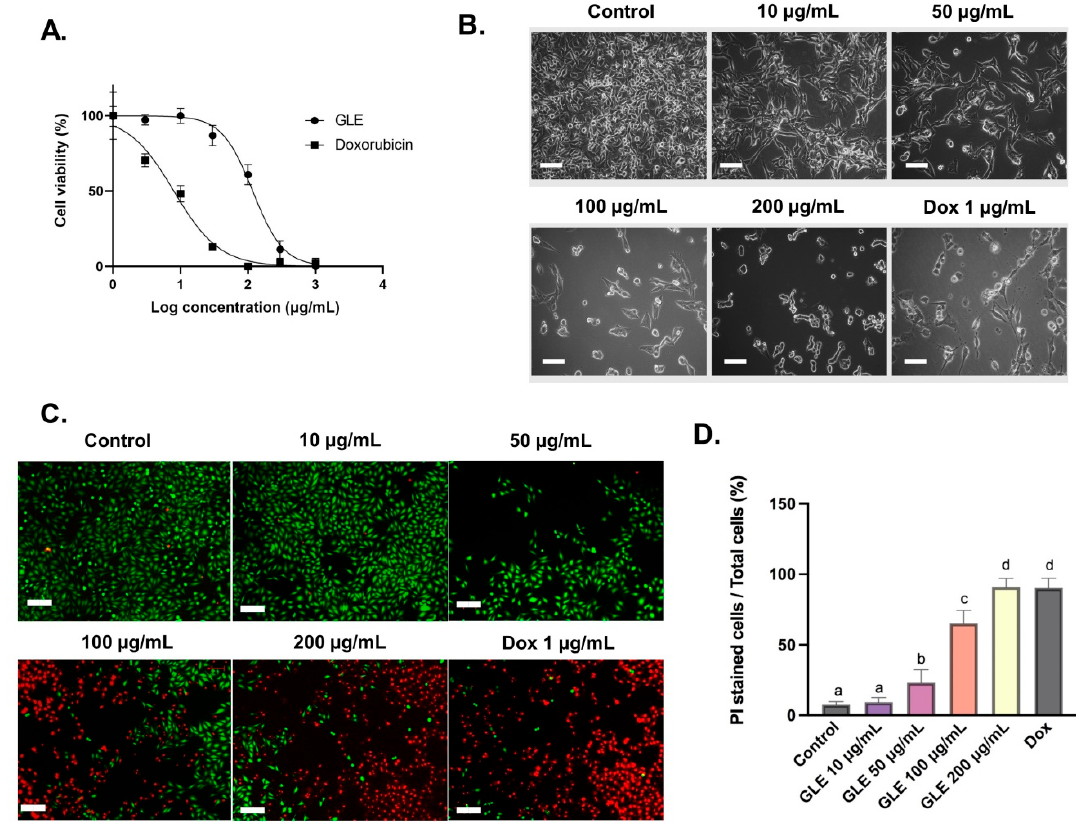
Figure 3. Cytotoxic effects of GLE in B16-F10 cells treated for 72 h: ( A ) The dose–response curve of GLE and doxorubicin (1–1000 µg/mL) cytotoxic activity in B16-F10 melanoma cells. ( B ) Morphological observation of B16-F10 melanoma cancer cells treated with GLE or doxorubicin for 72 h, scale = 50 µm. ( C ) Viability staining with calcein-AM (green) and PI (red) in B16-F10 murine melanoma cells treated with GLE or doxorubicin for 72 h. ( D ) The percentage of PI-stained cells represent dead cells. Different letters denote significant differences between treatments. Scale = 100 µm.